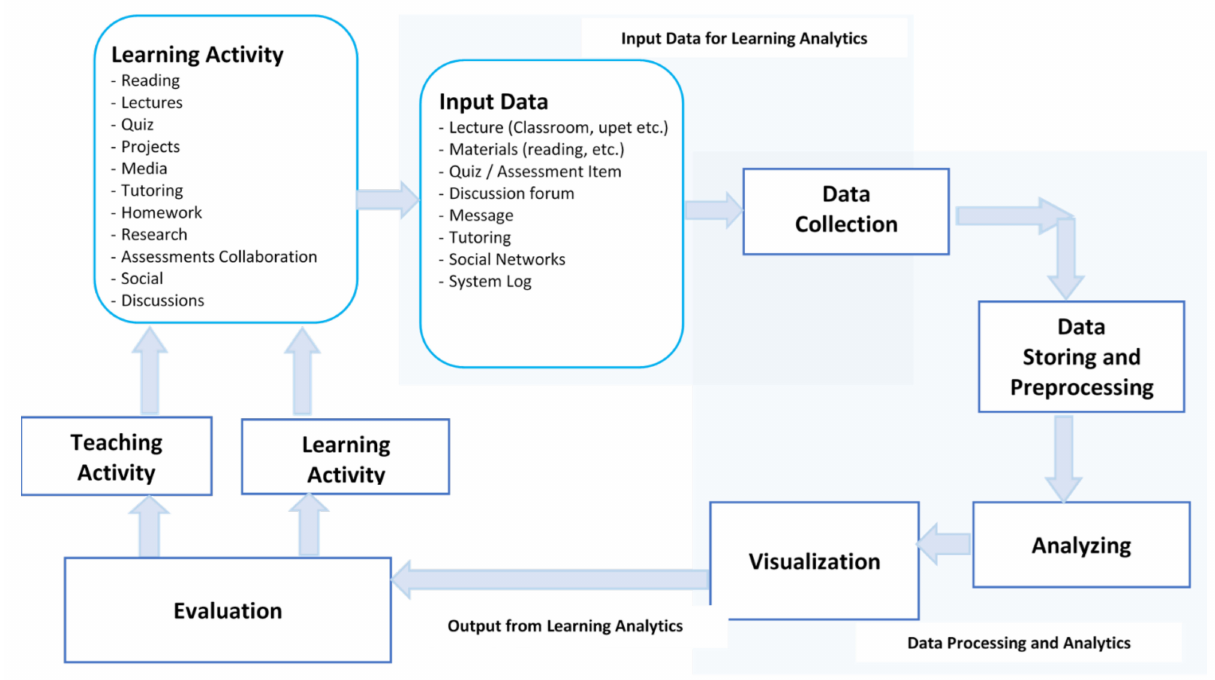
Figure 2. The learning analytics and evaluation model proposed by the authors for designing the EvalMathI system in ERT cases, based on virtual